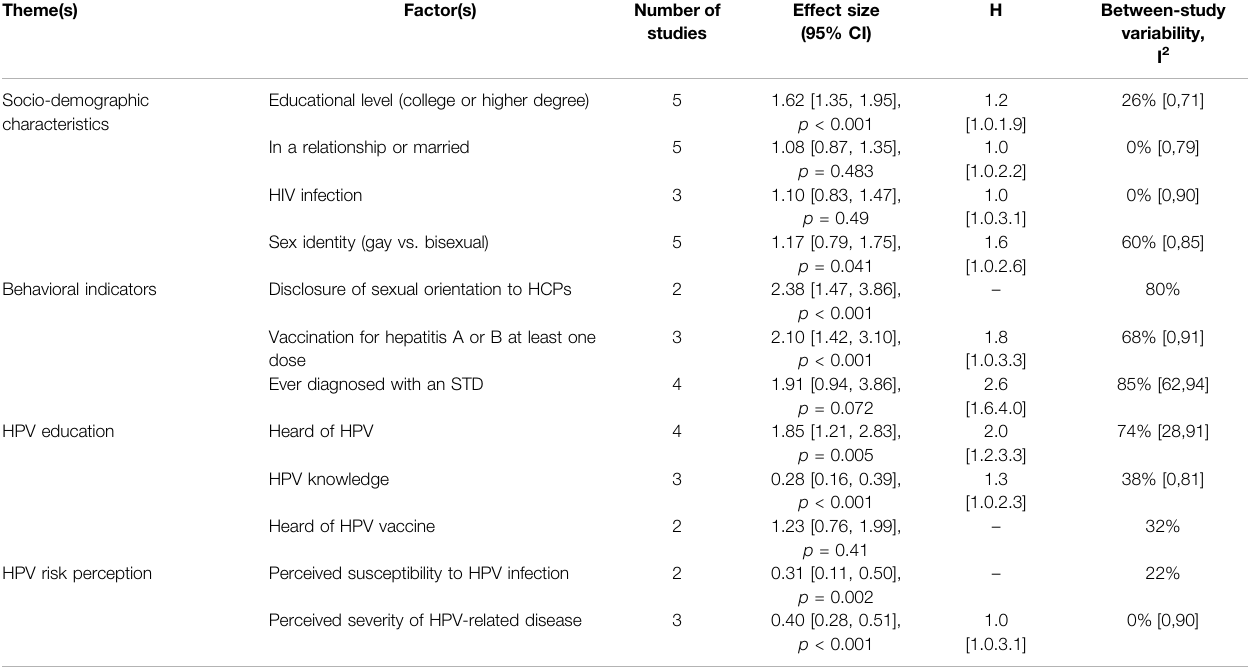
TABLE 3 | Meta-analysis of correlates of human papillomavirus (HPV) vaccine acceptability among MSM.